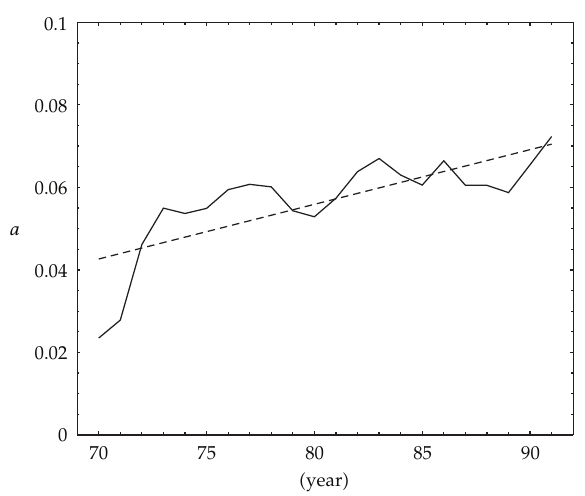
Figure 8: Plot of the “amplitude” a for the years 1970–1991. The dashed line gives the best fit a (cid:7) 0 . 0013 x − 0 . 050. The steady increase of a , which is a sign of thinning out, is